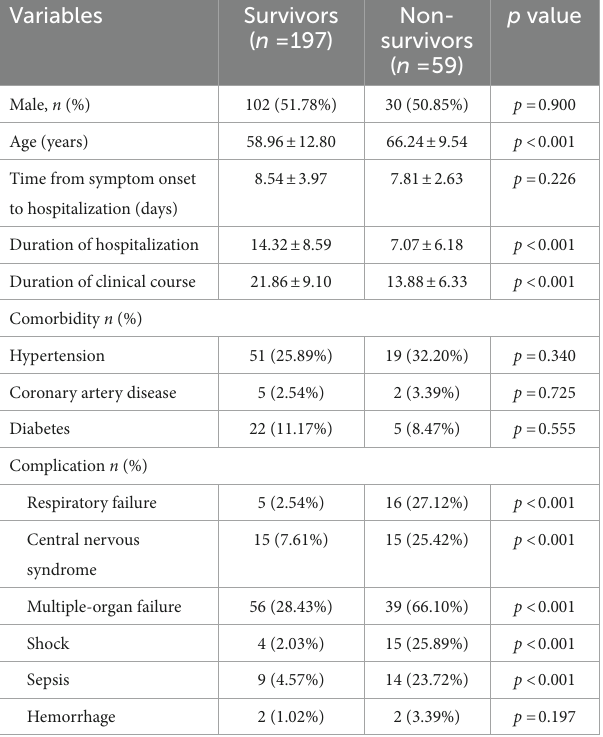
TABLE 1 Demographic characteristics of the patients with